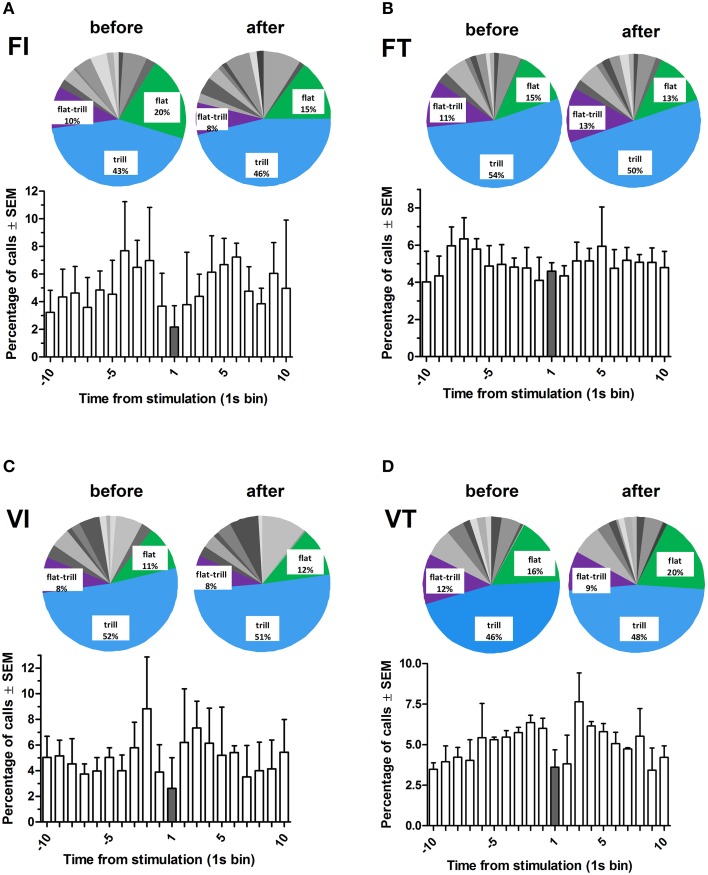
Percentage of total calls and call subtypes under each reinforcement schedule for all rats (n = 4), as a function of time from stimulation. Time bin “1” represents the time at which the midbrain optogenetic stimulation occurred. Pie charts show percentages of calls (14 subtypes and 2 categories) before (–10 to –1) and after (2–10) the stimulation. The most common calls are labeled (for details of call subtypes see Supplementary Table 5). FI, fixed interval; FT, fixed time; VI, variable interval; VT, variable time. All schedules are 20 s.